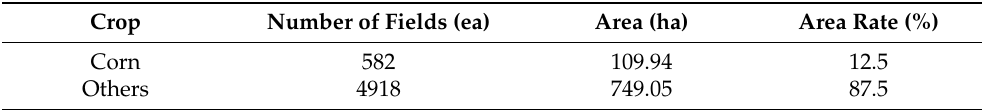
Table 4. Number of fields and cultivation area of corn and other crops for the entire agricultural land area in Gammul-myeon.